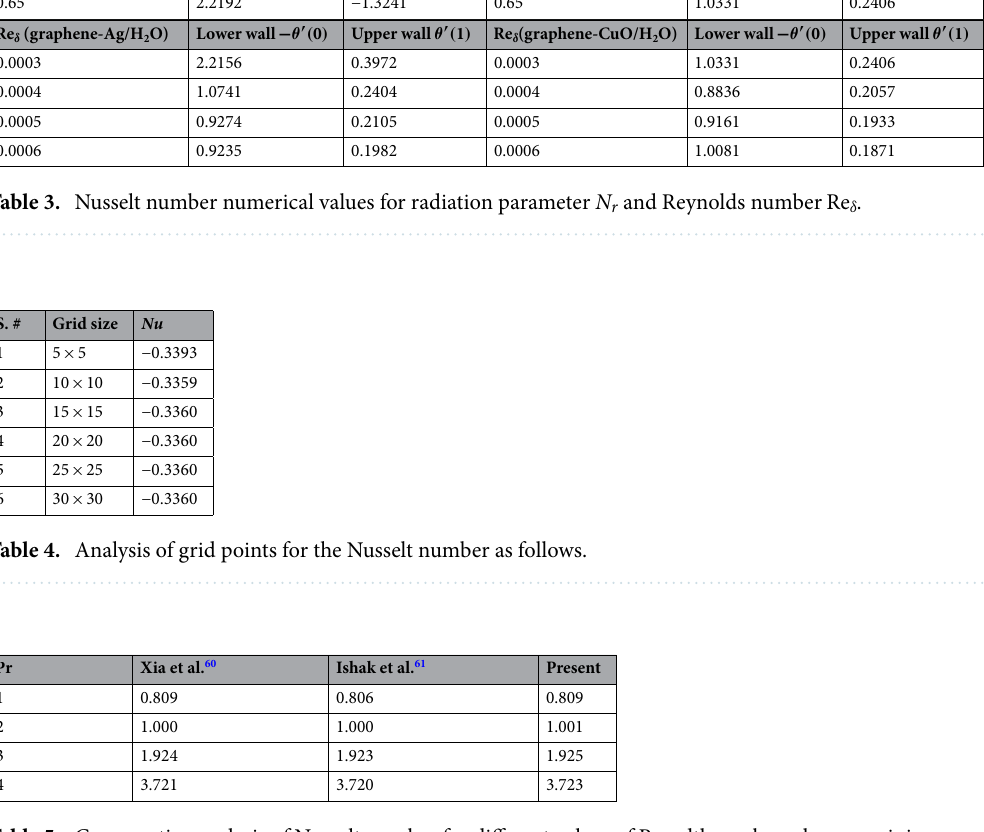
Table 5. Comparative analysis of Nusselt number for different values of Prandtl number when remaining parameters of temperature equation are zero.